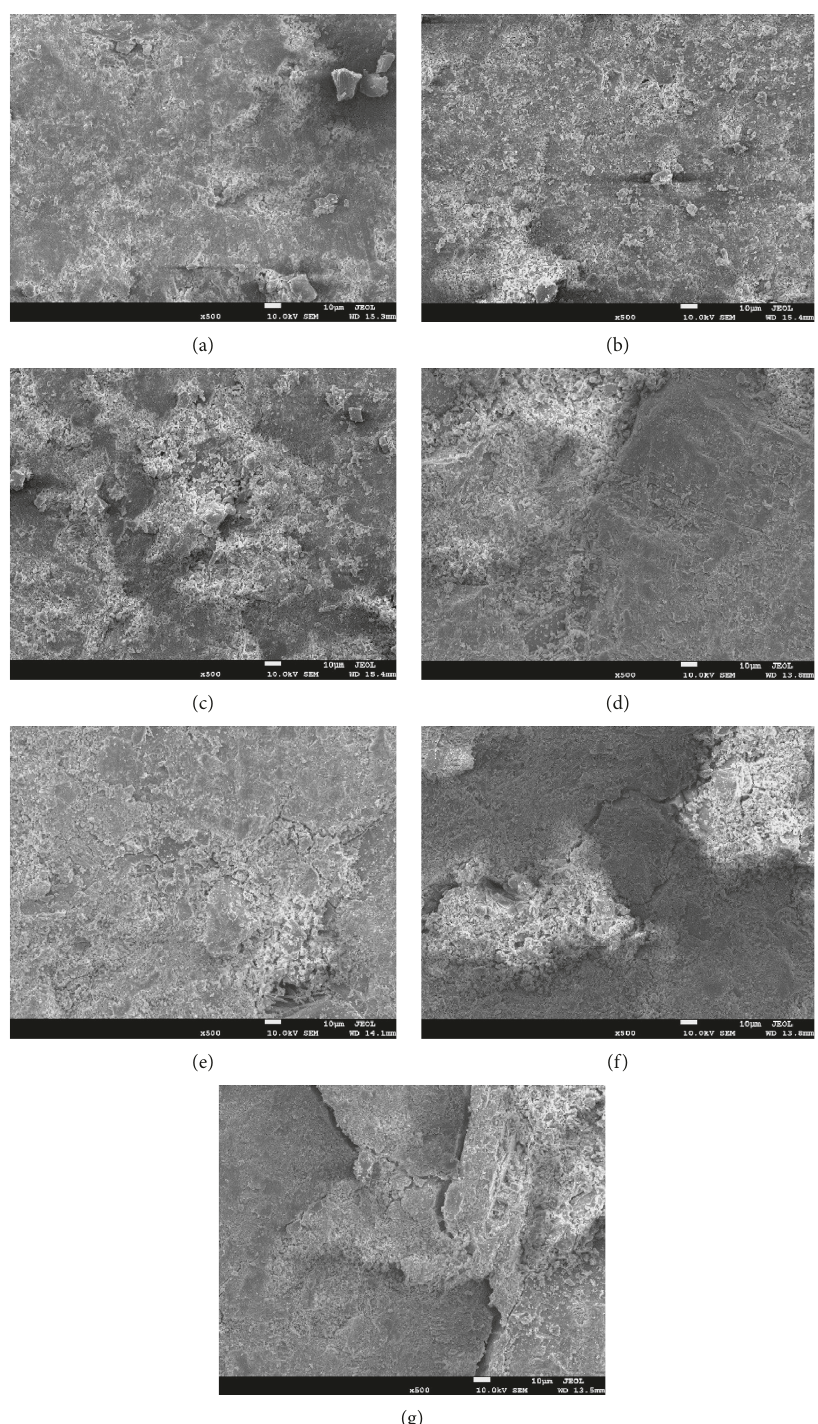
Figure 10: Fracture morphology of sandstone at different temperatures (SEM images): (a) 20 ° C; (b) 100 ° C; (c) 200 ° C; (d) 300 ° C; (e) 400 ° C; (f) 500 ° C; (g) 600 °